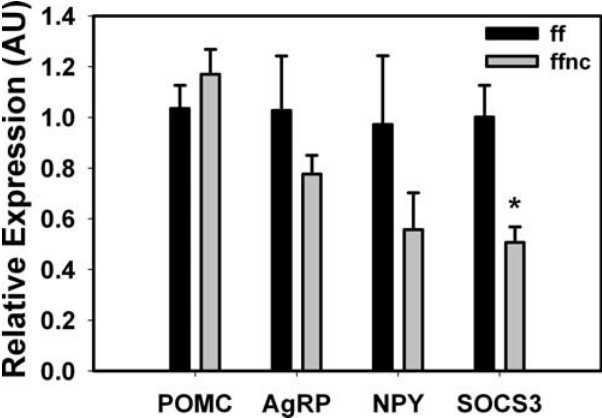
Figure 8. Expression of neuropeptide and regulatory genes in the Arc of Stat5 fl/fl control (ff) and Stat5 fl/fl ; Nestin-Cre (ffnc) female mice. Total RNA prepared from microdissected Arc tissue from ff and ffnc mice was subjected to semi-quantitative real-time PCR for POMC, AgRP, NPY and SOCS3 mRNA expression. n=9–10; * t (17)=3.7, p=0.002 by students t test, all other comparisons,